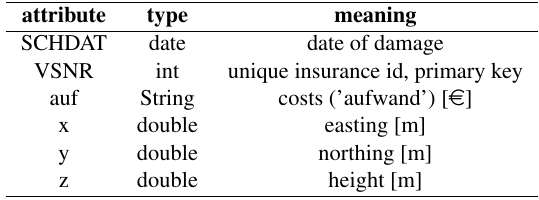
Table 3: Description of Damage Data attributes